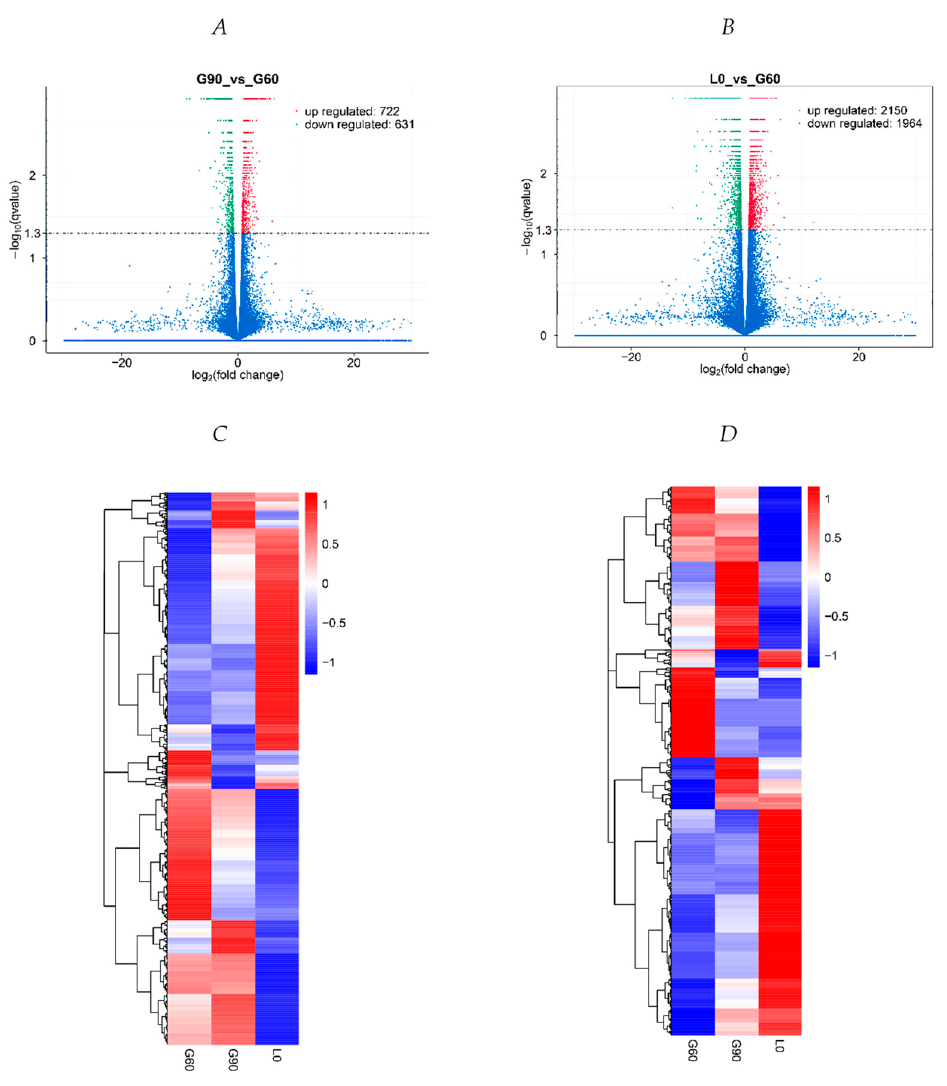
Figure 3. Transcriptome profile of RNA-seq data at G60, G90, and L0. ( A ) A volcano plot of differentially expressed transcripts, including mRNAs and long non-coding RNAs (lncRNAs), between G60 and G90, and ( B ) between G60 and L0. ( C ) Unsupervised hierarchical clustering of the expression profile of significant genes of mRNAs, and ( D ) lncRNAs among G60, G90, and L0.